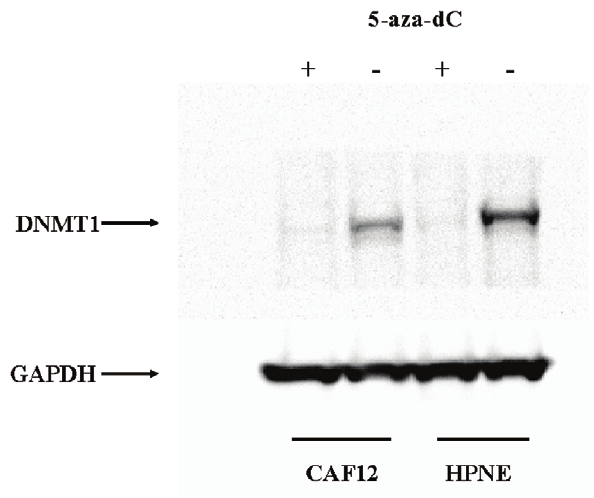
Figure 1. Effect of 5-aza-dC treatment on DNMT1 protein levels by Western blot analysis of pancreatic CAF and control fibroblast cultures. DNMT1 protein is depleted (relative to GAPDH) in 5-aza-dC treated HPNE and CAF12 cells.